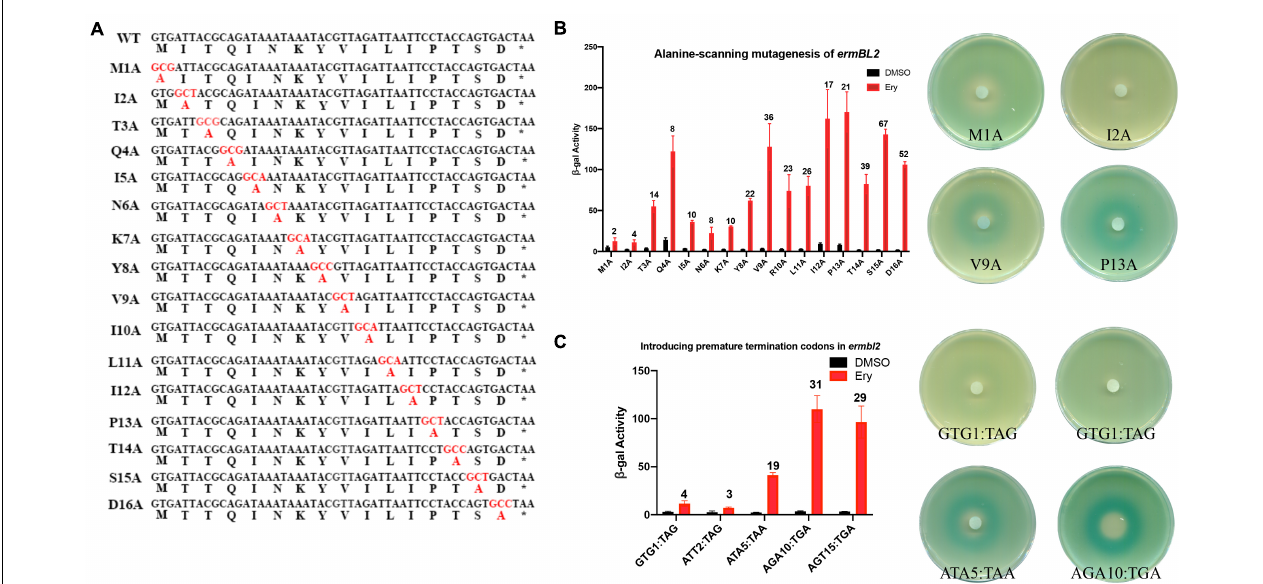
FIGURE 7 | (A) Amino acid sequences of ermBL2 peptide (WT) and its alanine-scanning mutations. 720 (B) β -Galactosidase activity and agar diffusion assays of the degree of Ery induction in 721 vivo following Ala mutation of ermBL2 amino acid sequences. (C) β -Galactosidase 722 activity and agar diffusion assays of the degree of Ery induction in vivo following 723 introduction of premature termination codons in ermBL2. Data are mean´sSEM from 724 three independent experiments. (unpaired two-tailed Student t test).